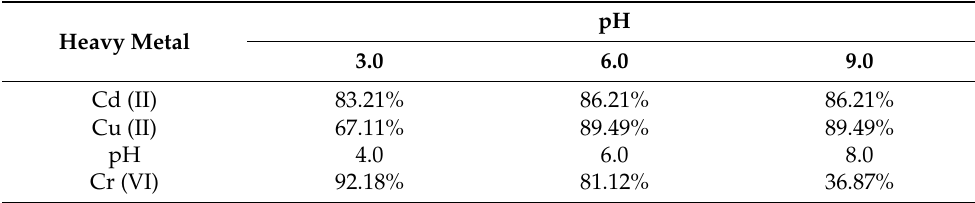
Table 6. Efficiencies of each metal varying pH.